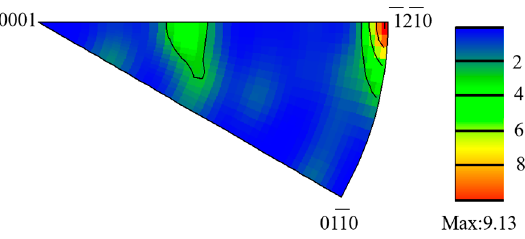
Figure 9. Inverse pole figure of